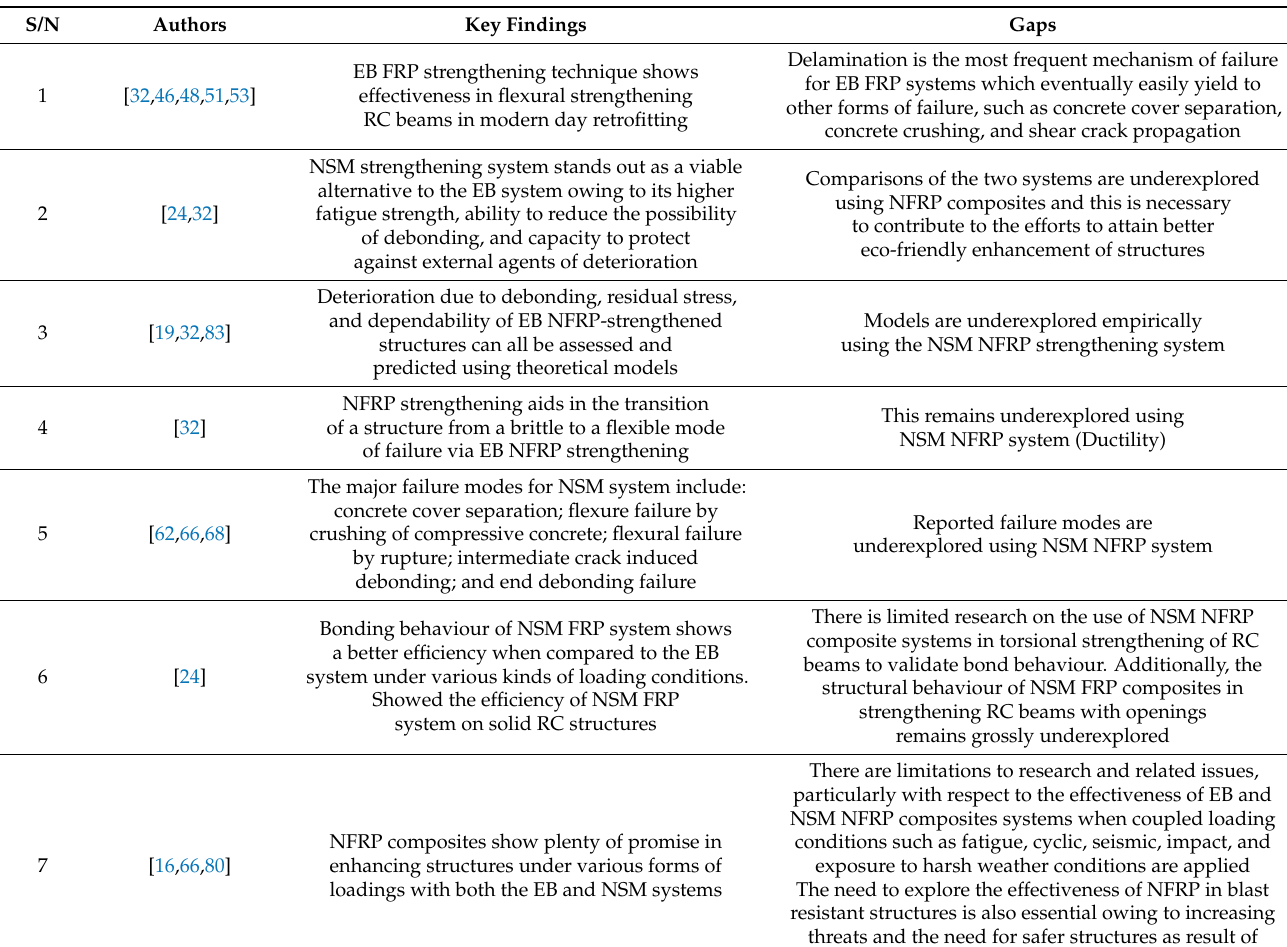
Table 6. Gaps in knowledge based on the literature review of past